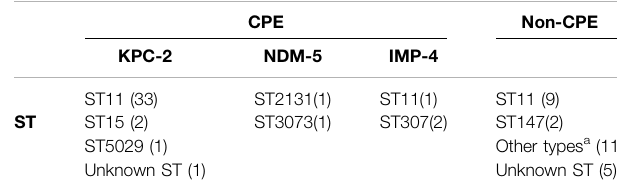
TABLE 2 | The MLST analysis of 69